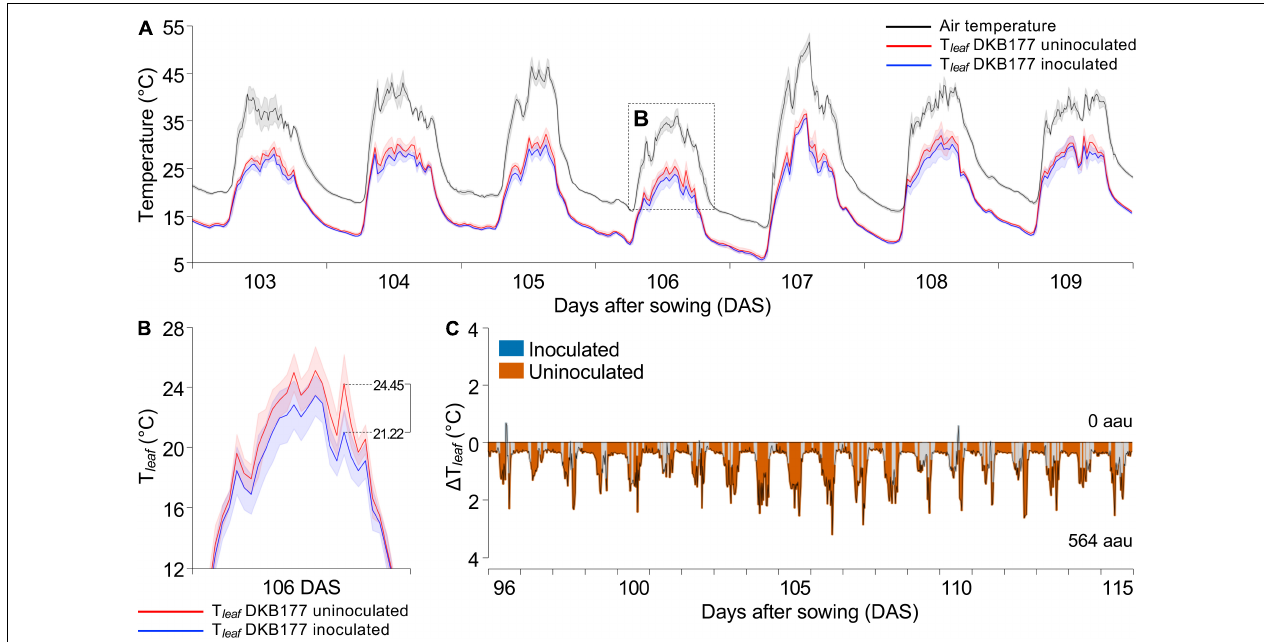
FIGURE 4 | The SynCom-inoculated DKB177 plants displayed lower T leaf than uninoculated plants. (A) The hybrid DKB177 showed a low T leaf when inoculated with SynCom, especially in periods when the air temperature was high. The standard deviation is shown as the background for air temperature and both treatments. (B) T leaf of uninoculated plants reaches a peak of 3.23 ◦ C higher at 106 DAS (inset from panel A ). (C) The difference between T leaf of inoculated and uninoculated plants ( (cid:49) T leaf ), rounded every 30 min over time, revealed consistency in the high temperature presented by uninoculated DKB177. Values were displayed above the x -axis when T leaf of inoculated plants is higher than T leaf of uninoculated plants or below the x -axis when T leaf of uninoculated plants is higher than T leaf of inoculated plants, and colored in blue or red, respectively, when significantly different ( P ≤ 0.05). Areas filled with light gray denote not statistically significant differences. The sums of areas in the graph above and below the x -axis were considered only for statistically significant differences. See Supplementary Figure 8 for the entire analyzed period. T leaf , leaf temperature; (cid:49) T leaf , difference of T leaf ; aau, arbitrary area units; DAS, days after